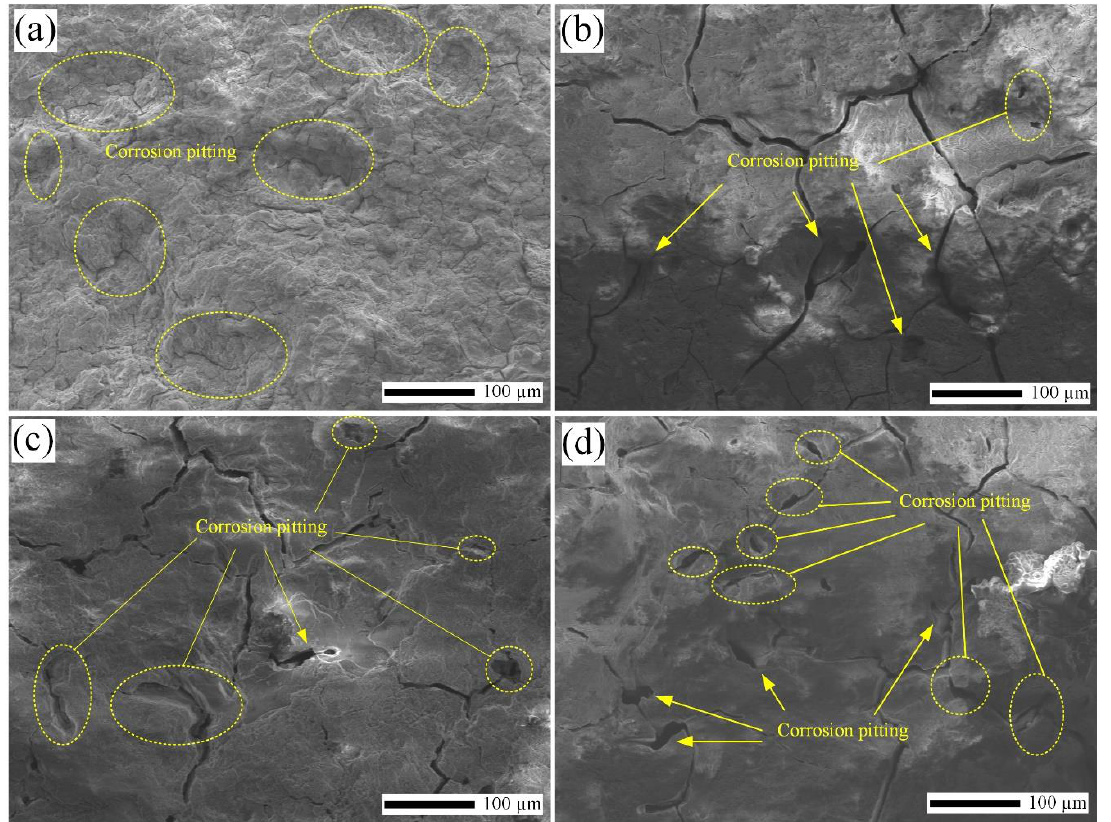
Figure 12. SEM photographs of corrosion pitting pits on the surface of magnesium before and after laser shock peening: ( a ) untreated; ( b ) 1.19 GW/cm 2 ; ( c ) 1.99 GW/cm 2 ; ( d ) 2.79 GW/cm 2 .